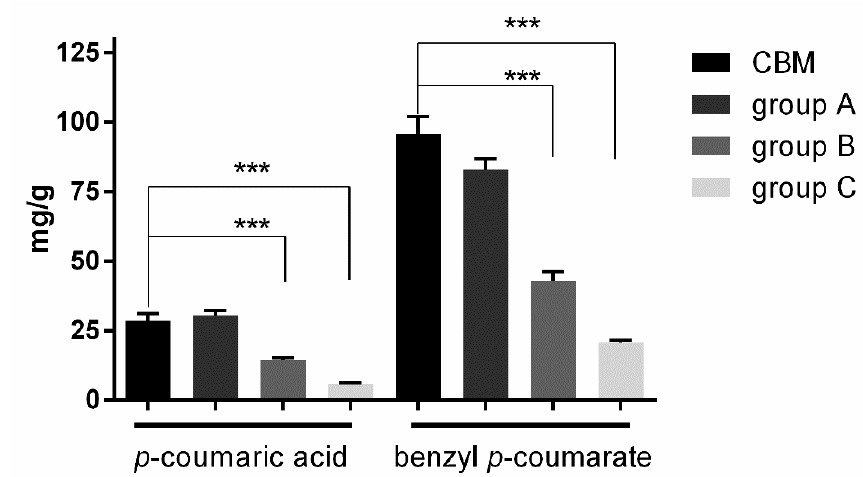
Figure 4. The contents of p -coumaric acid and benzyl p -coumarate in CBM and different groups propolis. Each value represents the mean ± SEM, *** P < 0.0001 by Student's t-test.